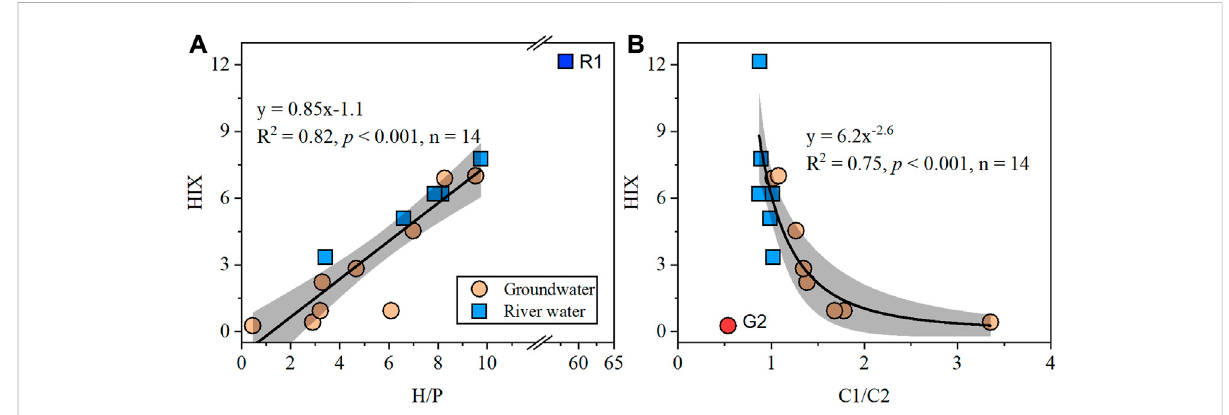
FIGURE 5 Relationships between (A) HIX and H/P and (B) HIX and C1/C2 in groundwater and river water samples. Sample R1 and G2 were excluded in the linear and exponential fi ttings (black solid lines), respectively. Gray shadows represent the 95% con fi dence bands for the fi tting